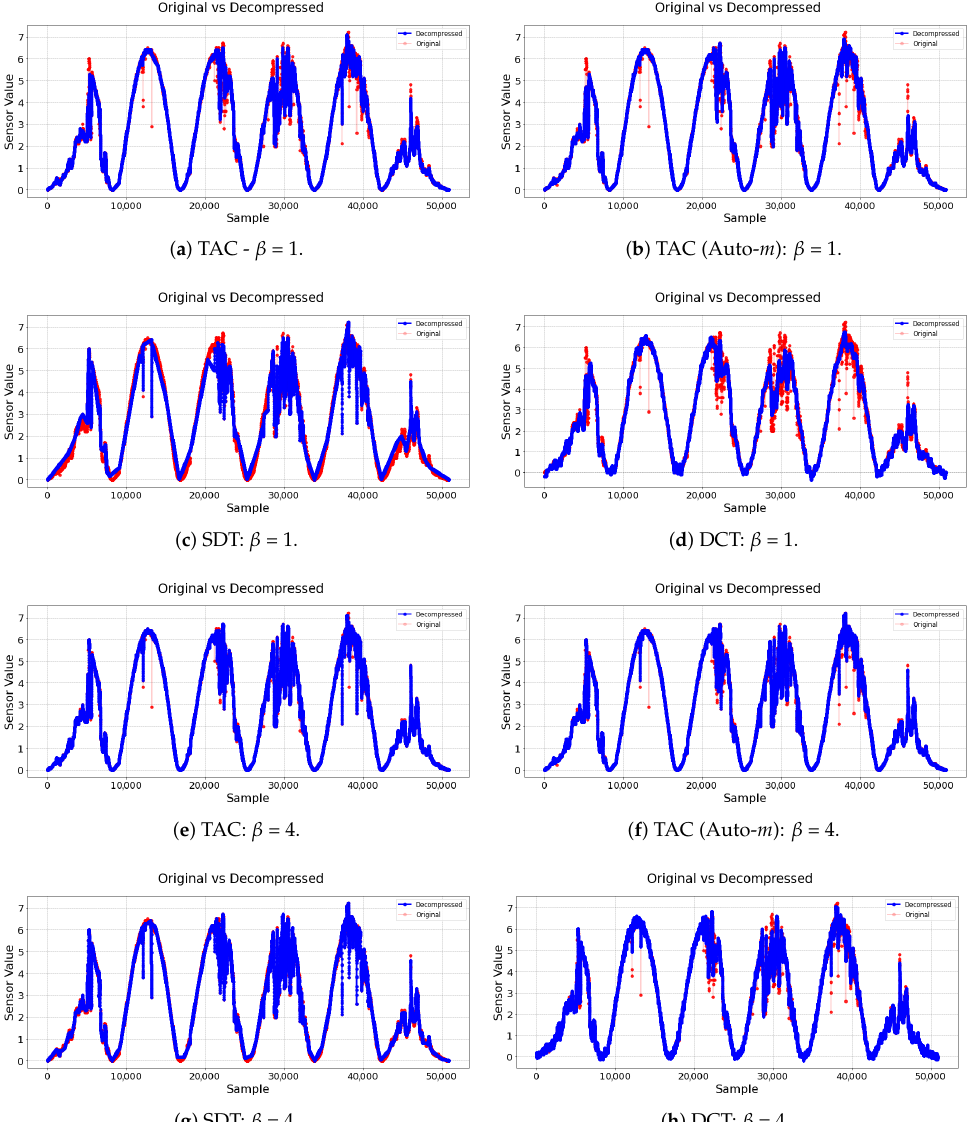
Figure 5. Original and decompressed signals: Dataset